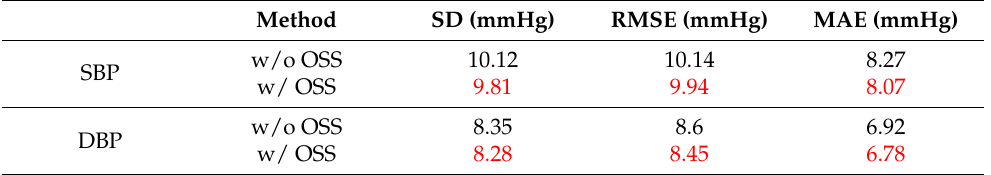
Table 3. Comparison of the performance of different networks.